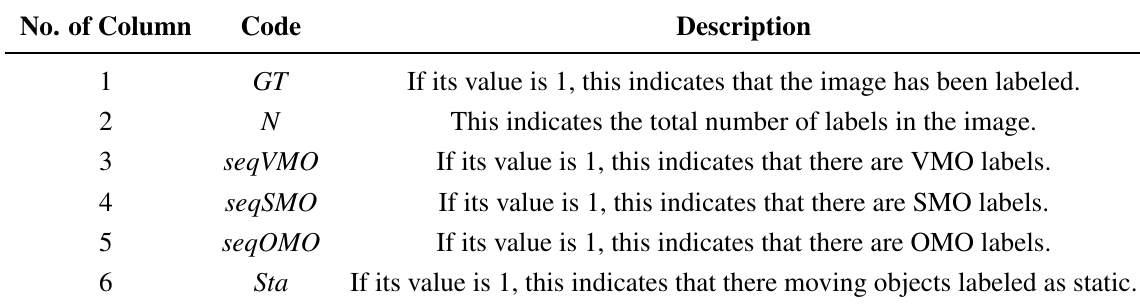
Table 1. Fields in seqMatrix.